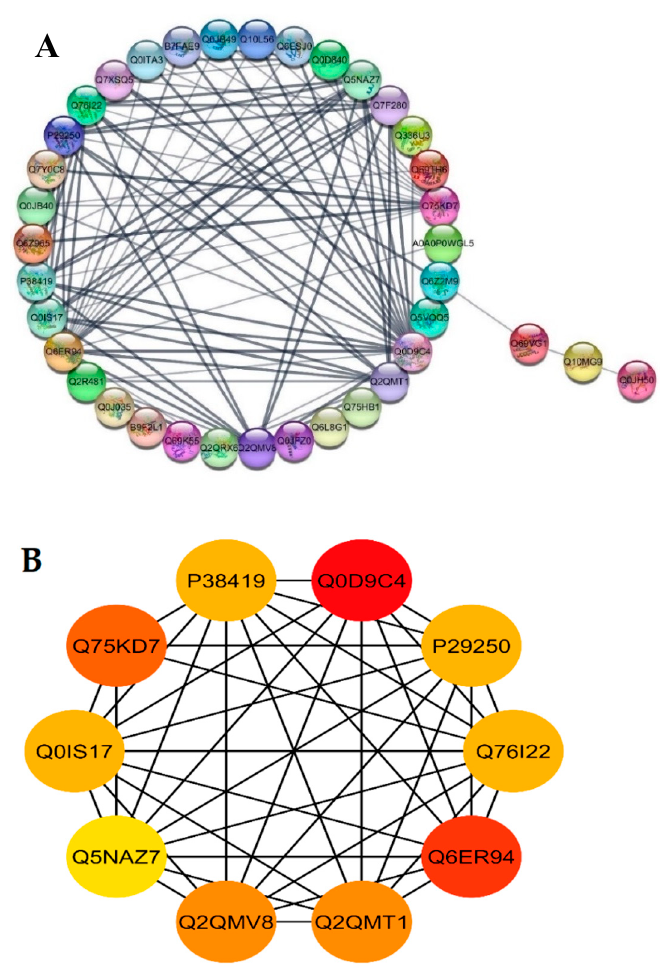
Figure 6. Functional networks of DEPs and hub-protein analysis of WT and mutant line GXU43_9. ( A ) STRING software predicted proteins’ associations. The nodes represent differentially expressed proteins, while the edge denotes the interaction relationship between the nodes. ( B ) The top hub-proteins of WT and GXU43_9 comparison. The higher co-expression is denoted by red color.